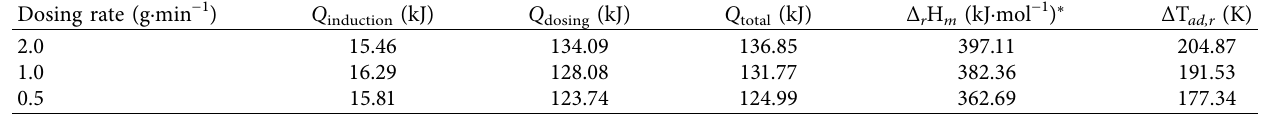
Table 2: Thermal parameters for synthesis of Grignard reagent, determined using SIMULAR.